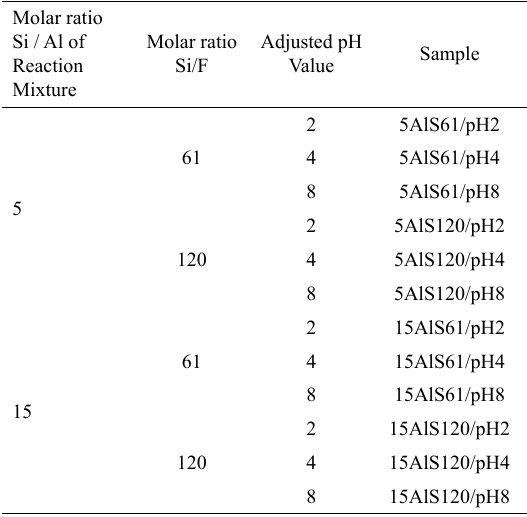
Table 1. Summary of synthesis conditions with pH adjustment of Al/SBA15 and sample nomenclature. Molar ratio Si / Al of Molar ratio Reaction Mixture